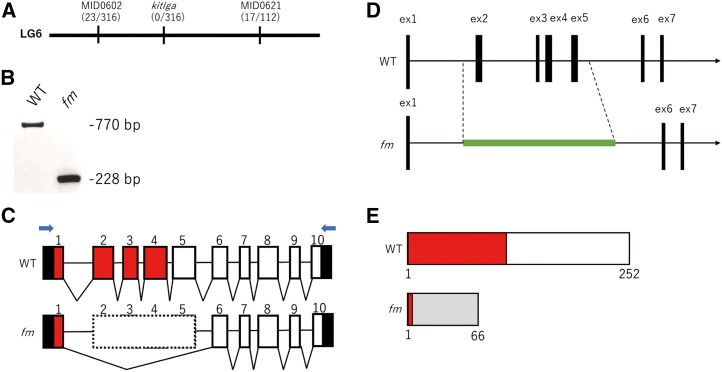
Mapping of the fm locus. (A) The fm locus was mapped to the region between MID0602 and MID0621 in linkage group 6 (LG6). A kitlga gene marker did not show any recombination with the fm phenotype (indicated by the numbers in parentheses). (B) RT-PCR analysis of total RNA from WT and fm medaka with the primer set indicated by the blue arrows in (C). (C) The kitlga gene of WT medaka comprises 10 exons (numbered boxes). Sequencing of cDNA generated by 5′-RACE showed that exons 2 to 5 are skipped in the fm mutant (box with dotted line). The 5′ and 3′ untranslated regions are shown in black, and exonic sequence encoding the SCF domain in red. (D) Sequencing of genomic DNA revealed that exons 2 to 5 (3.6 kb) of kitlga are replaced with a 3.9-kb sequence (green line) in the fm genome. (E) The WT kitlga gene encodes a 252–amino acid protein containing an SCF domain (red box). The fm mutation is predicted to result in the generation of a truncated protein, with the gray box representing the altered frame.